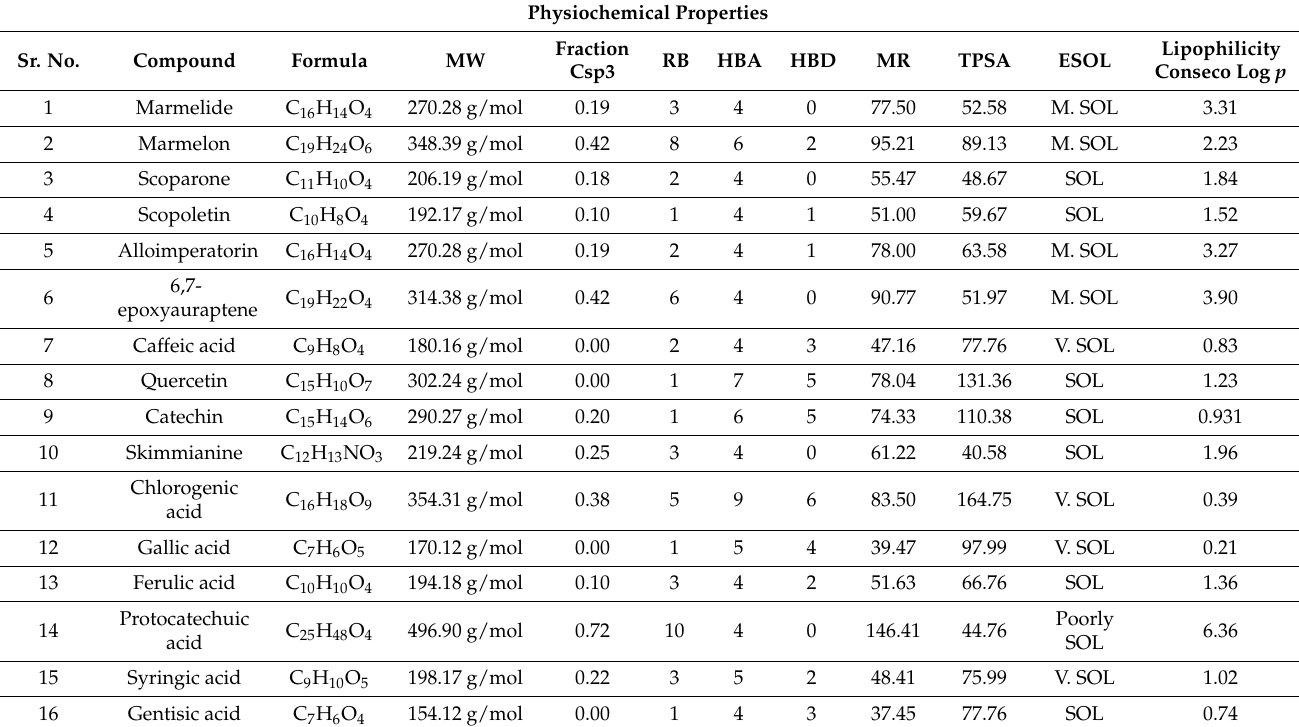
Table 4. Physiochemical prediction of selected compounds of A.